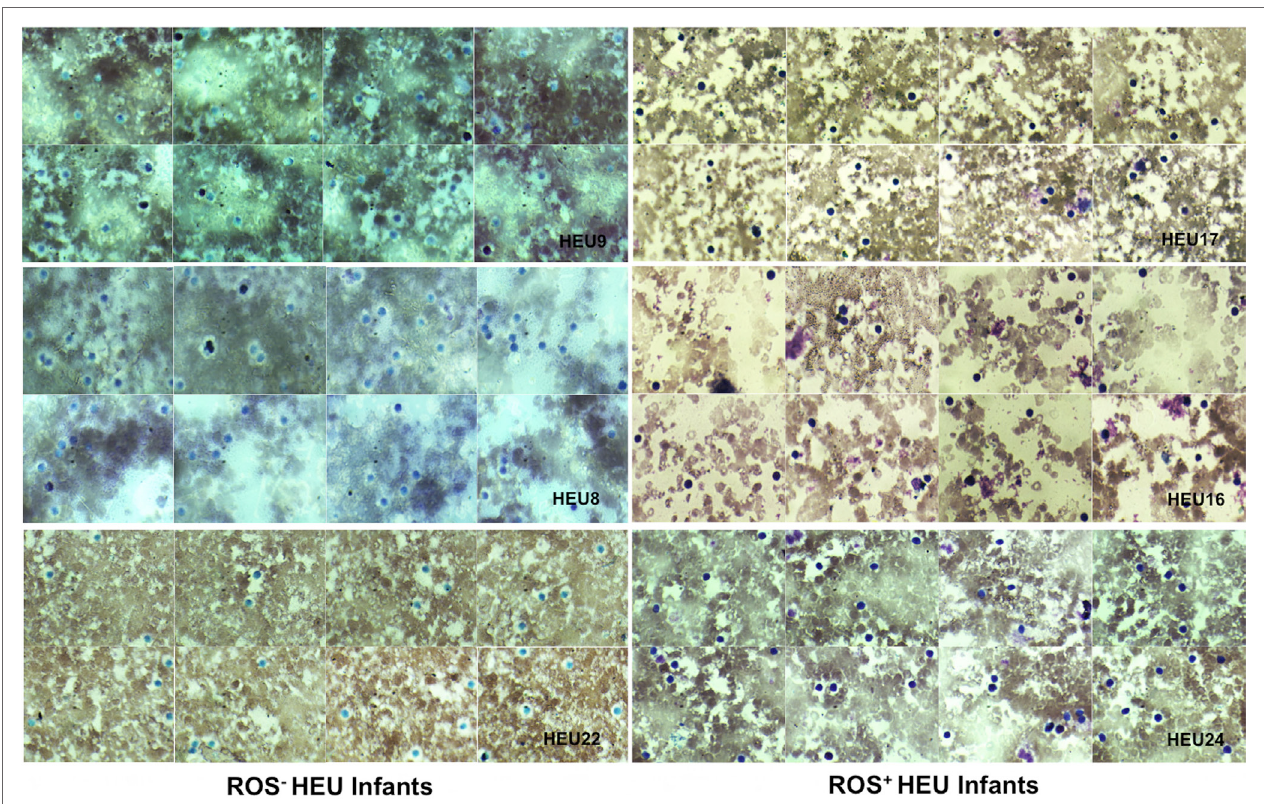
FigUre 2 | Photomicrographs of nitroblue tetrazolium (nBT) dye reduction profiles of selected hiV-exposed uninfected (heU) infants blood neutrophils (at × 100 magnification) . Reactive oxygen species (ROS) − HEU infants indicate infants with impaired ROS production. ROS + HEU infants indicate infants with normal ROS production. ROS + HEU infants illustrated by HEU 17, 16, and 27 showed increased formazan deposits visible as a large dark purple to black intra-cytoplasmic inclusions whereas, ROS − HEU infants illustrated by HEU 8, 9, and 22 showed few or no formazan